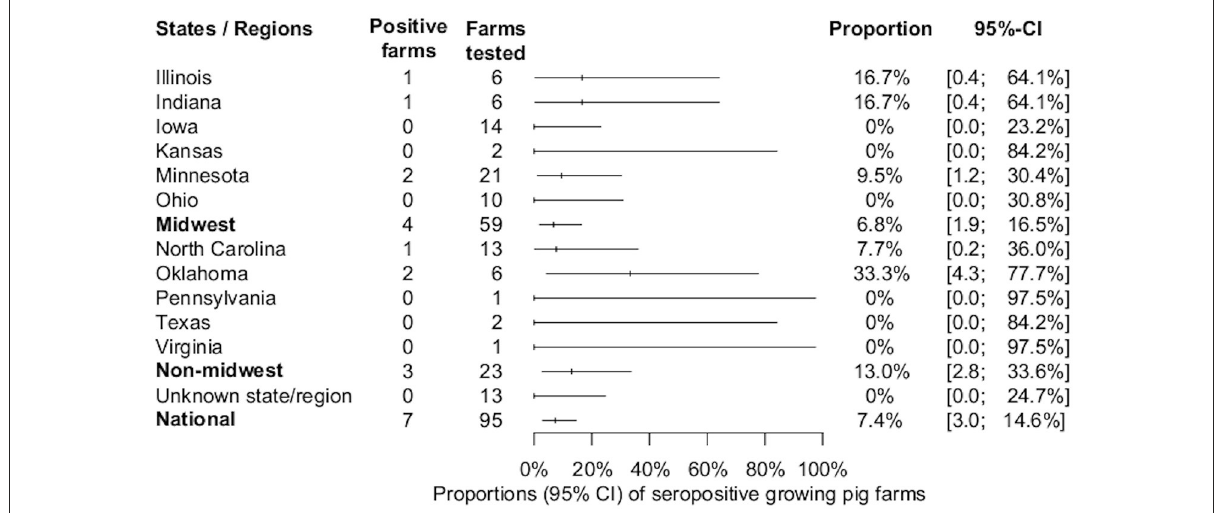
FIGURE3 Estimated proportions and 95% confidence intervals of SVA-seropositive growing-pig farms, by state, region, and national estimate.